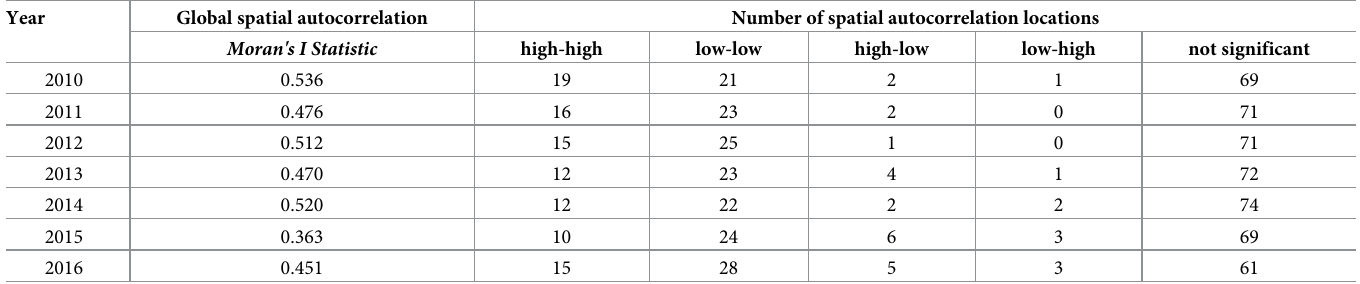
Table 3. Spatial autocorrelation analysis of tuberculosis notification results from 2010 to